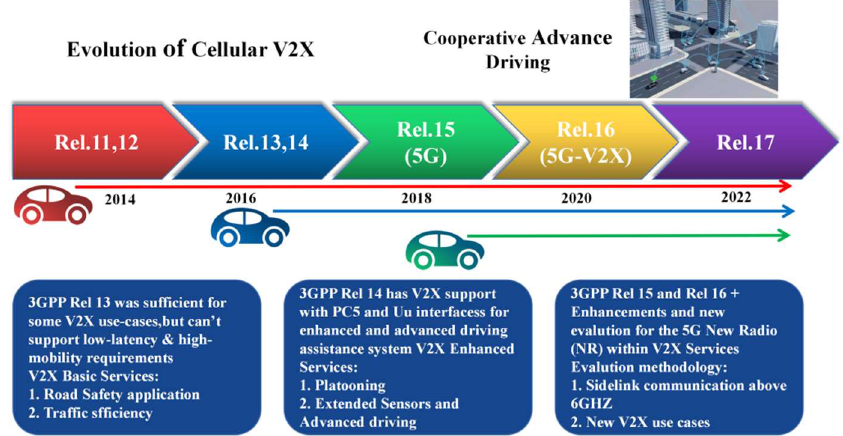
Figure 6. C-V2X standardization and evaluation.